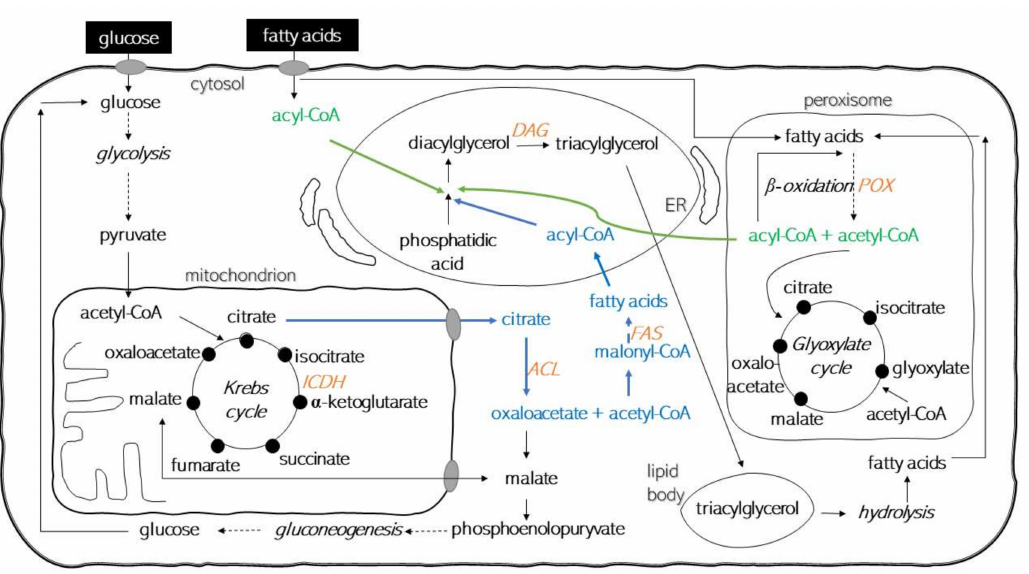
Figure 1. Overview of de novo (blue color) and ex novo (green color) pathways involved in lipid metabolism and their link with glyoxylate and the TCA cycles (in yeast cell?). The dashed line represents the multistep process. Orange abbreviations represent genes encoding key enzymes inves- tigated in the study: ACL —ATP-citrate lyase, FAS —fatty acid synthase, ICDH —NADP-dependent isocitrate dehydrogenase, DAG —diacylglycerol acyltransferase, POX —acyl-coenzyme A oxidase (adopted and modified after